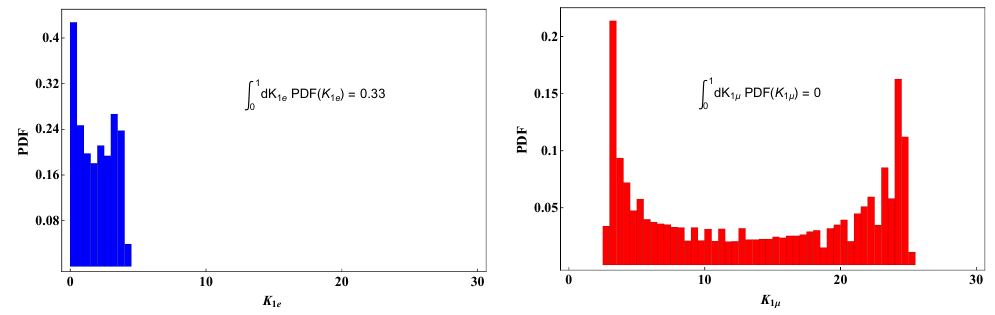
Figure 13 . Distributions of the (cid:13)avoured decay parameters. The probability for the electron decay parameter K 1 e being less than 1 is almost 33% which corresponds to the fact that asymmetry generated by N 2 is most likely to survive against N 1 washout in the electron (cid:13)avour.